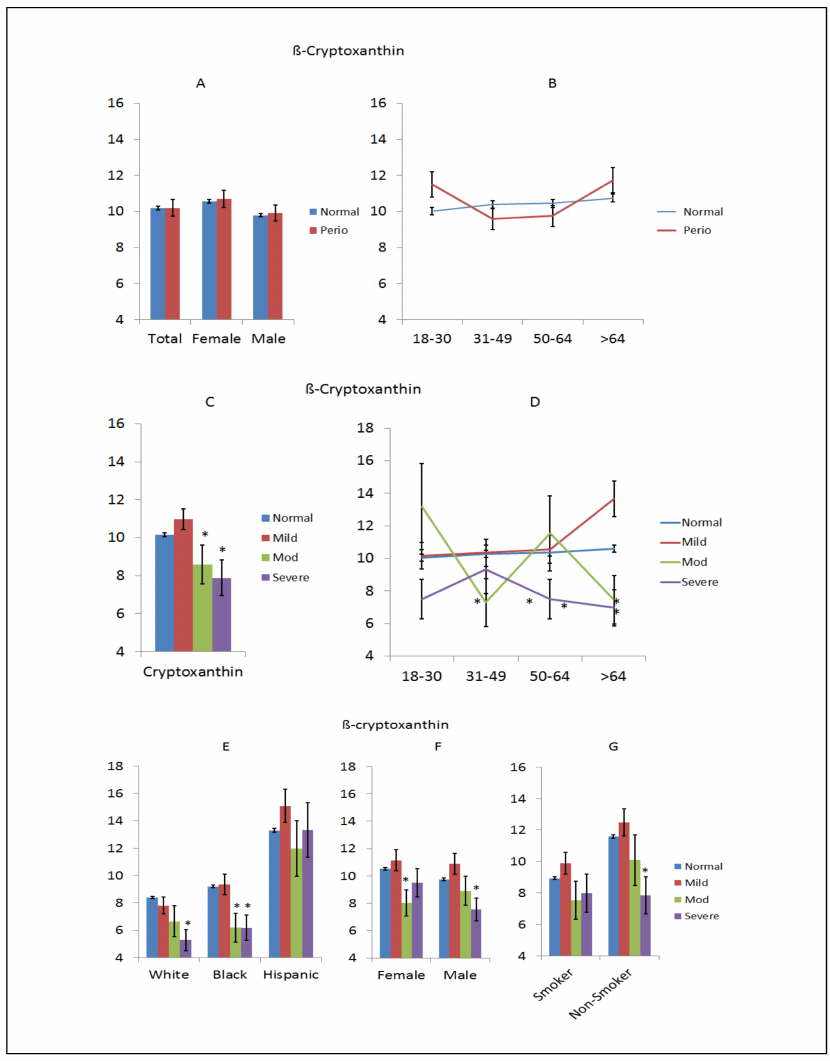
Figure 2. Levels of β -cryptoxanthin in subjects with or without periodontitis stratified upon sex ( A ), age ( B ), disease severity ( C ), disease severity and age ( D ), race/ethnicity ( E ), disease severity and sex ( F ), and disease severity in smokers ( G ). The bars denote group means and the vertical brackets enclose 1 SEM. The asterisk (*) denotes significantly different that other group(s) at p <